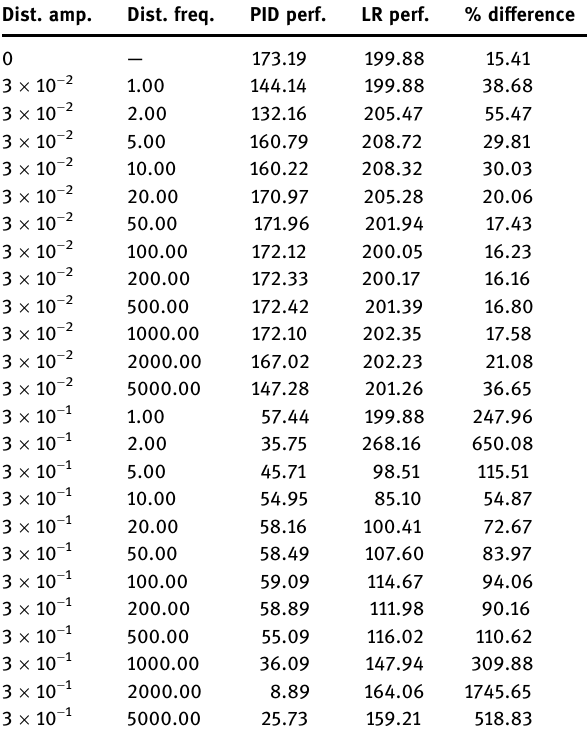
Table 2: Performance comparison of two control methods Dist.